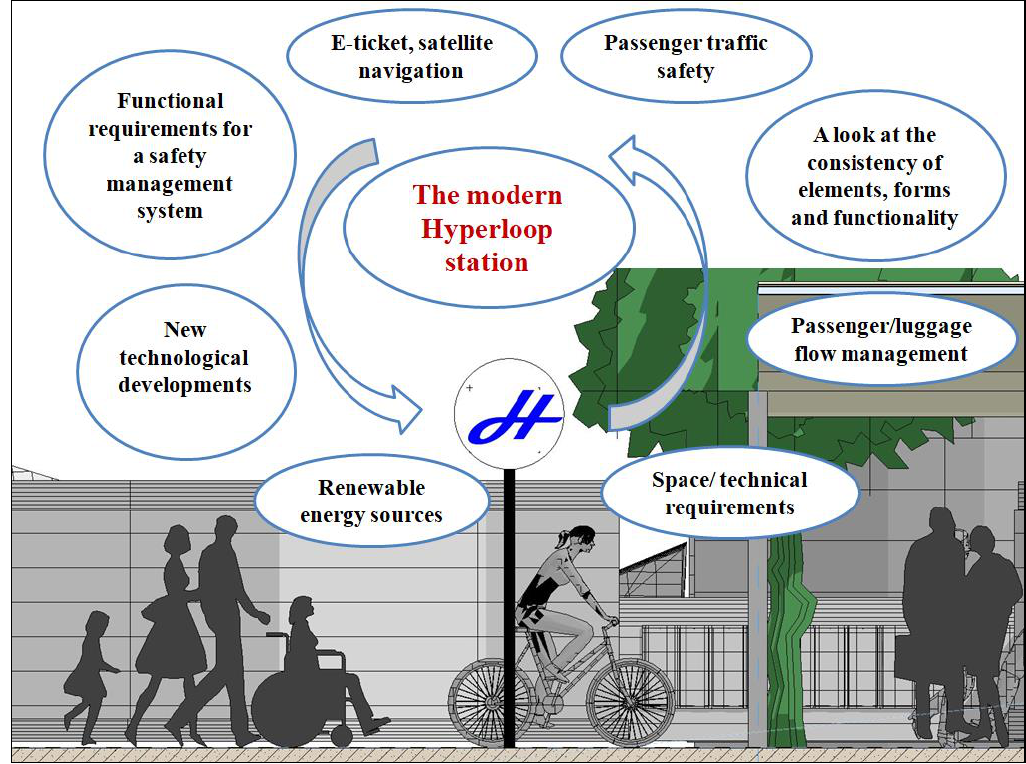
Figure 6. Main aspects to be covered in a Hyperloop station building design.